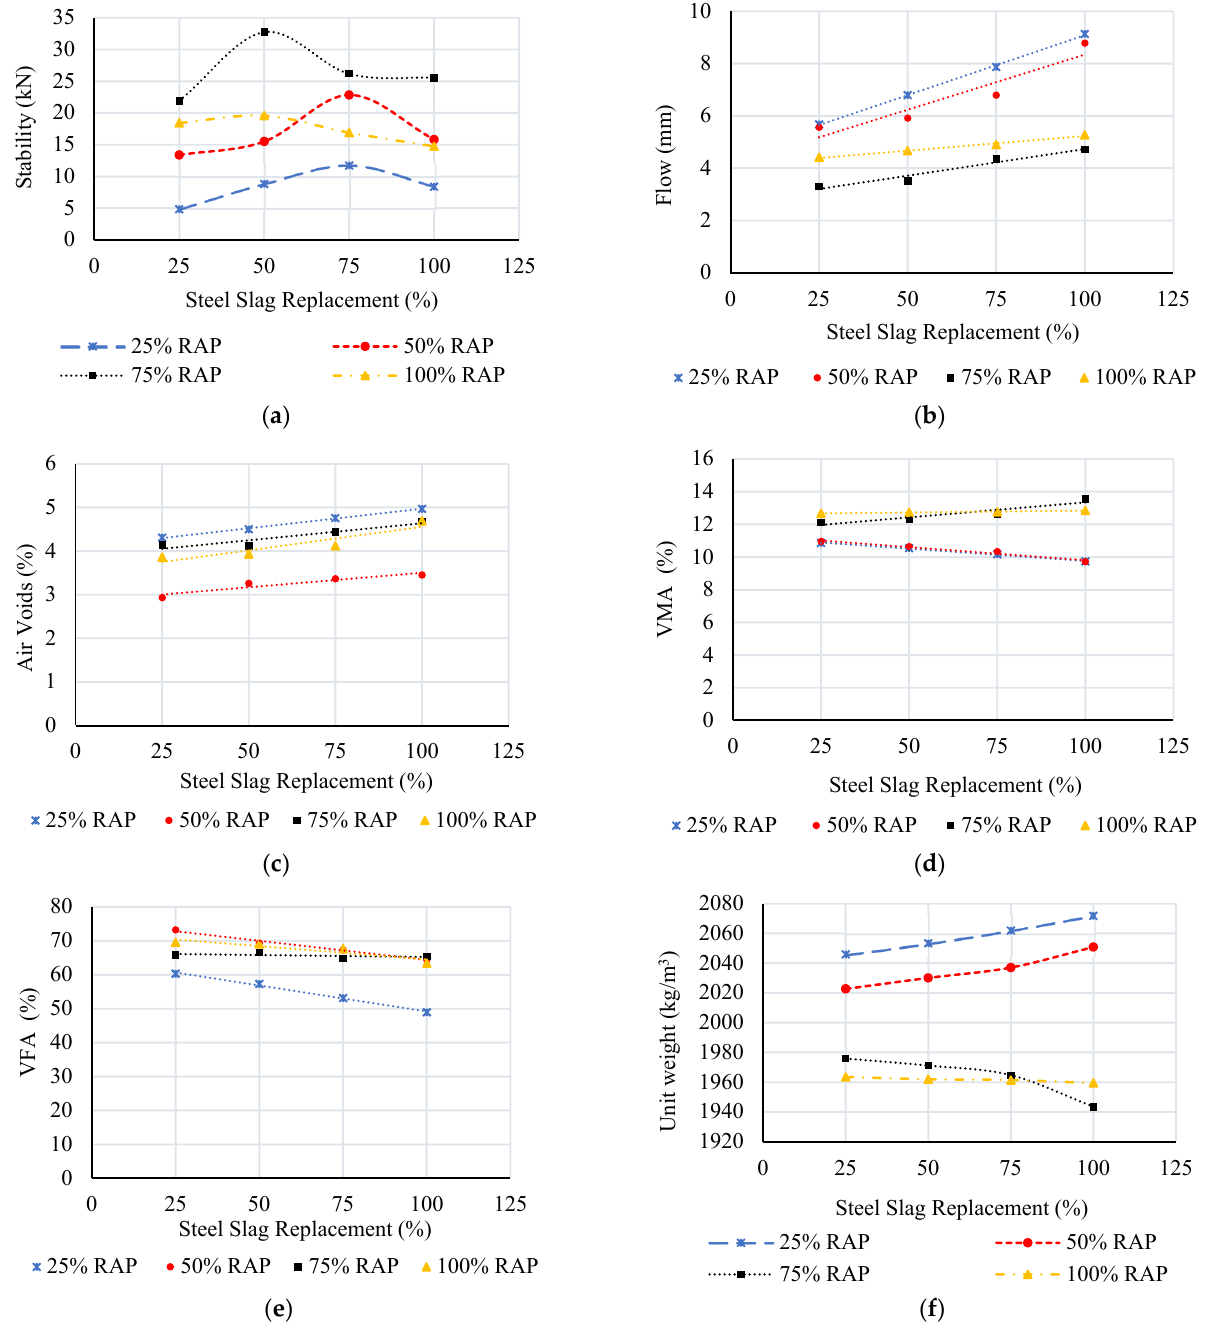
Figure 5. Test results of the RAP mix prepared with steel slag material in terms of ( a ) Marshall stability; ( b ) flow; ( c ) unit weight; ( d ) air voids; ( e ) VMA; ( f ) VFA. Table 5. Test results for the RAP mixes containing steel slag.